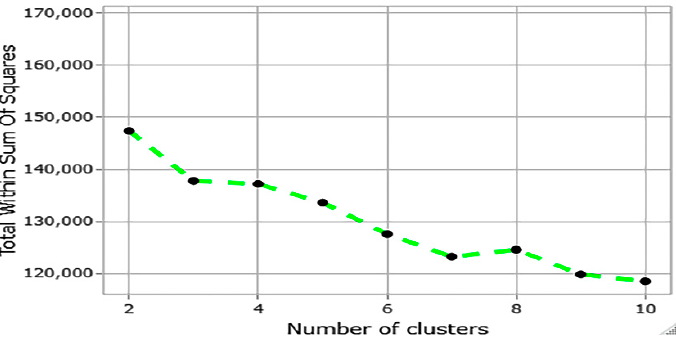
Figure 1. Optimal number of clusters.